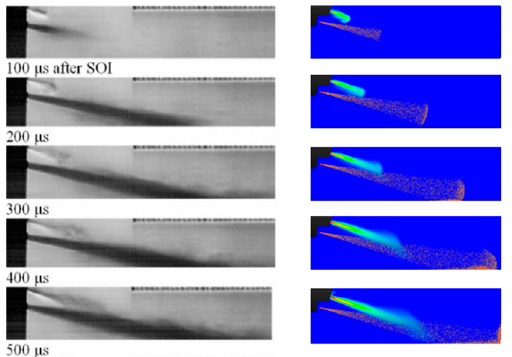
Figure 1. Comparison of interaction between gas jet and diesel spray: experimental data on the left and simulation result on the right.